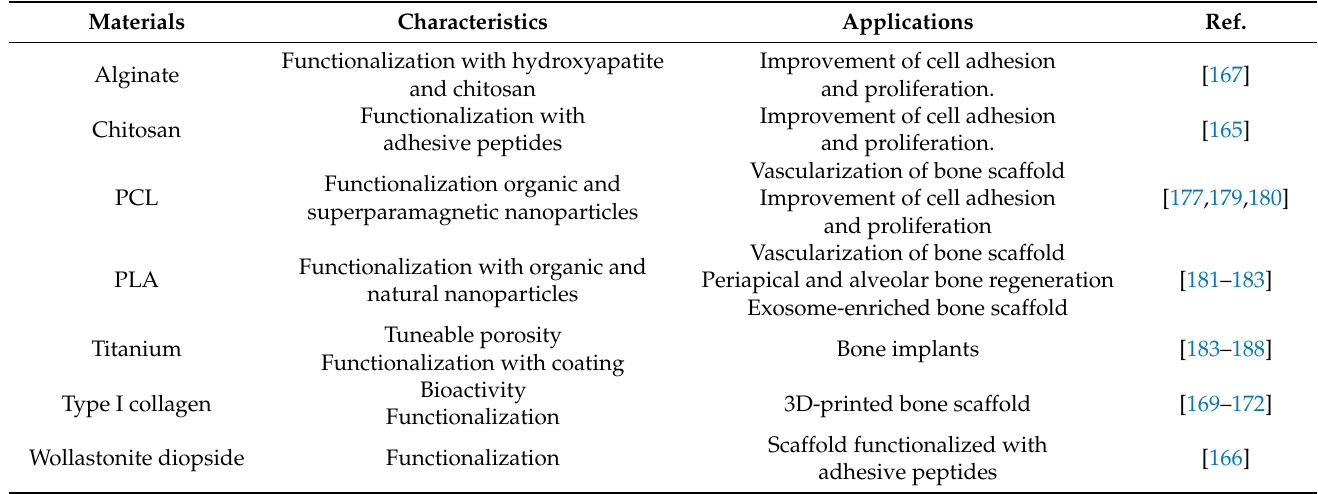
Table 6. Characteristics and applications of biomaterials on bone